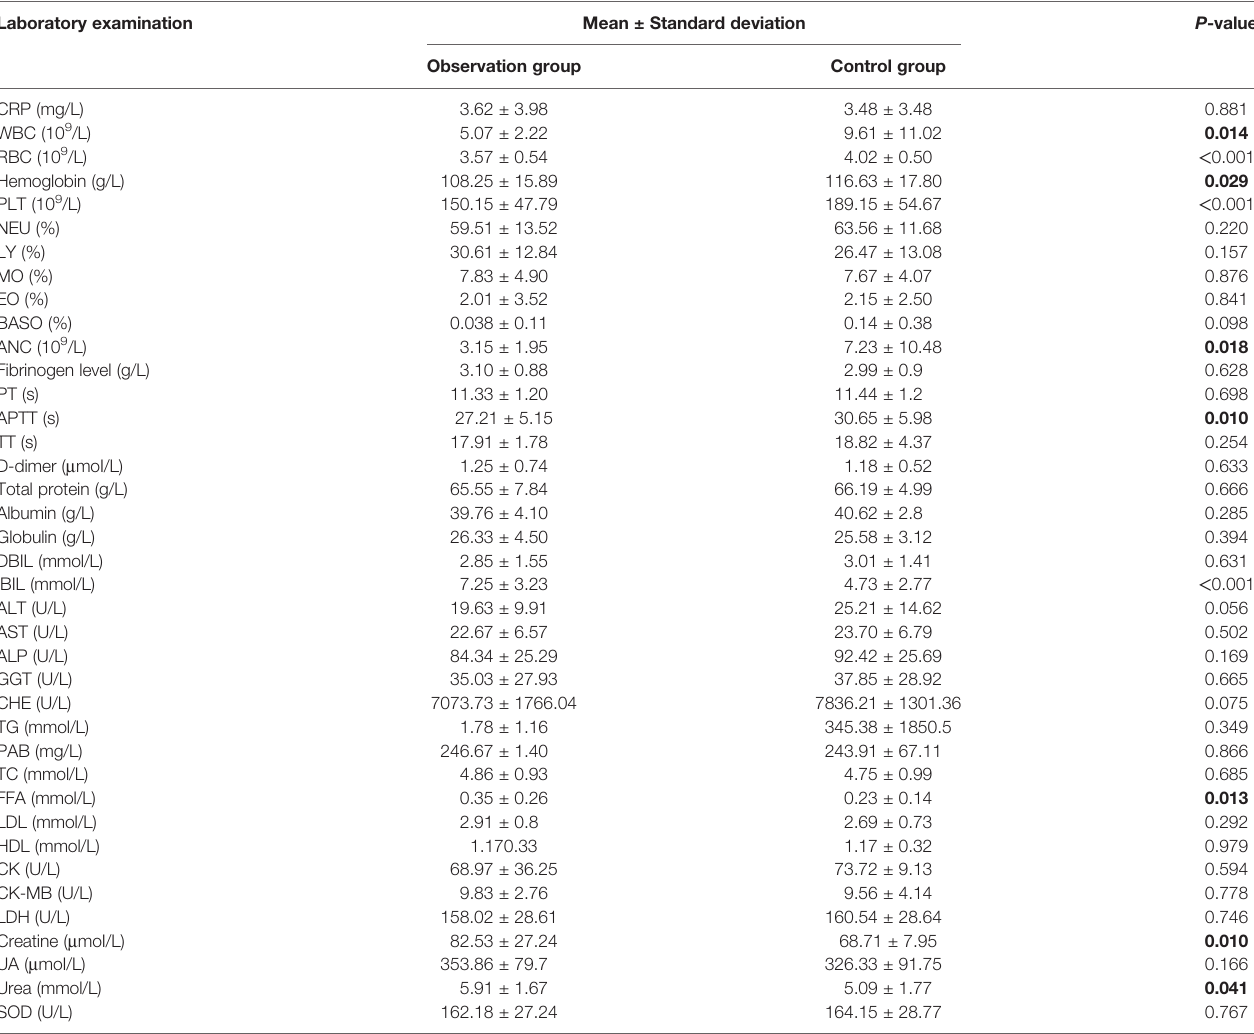
TABLE 3 | Laboratory examination before